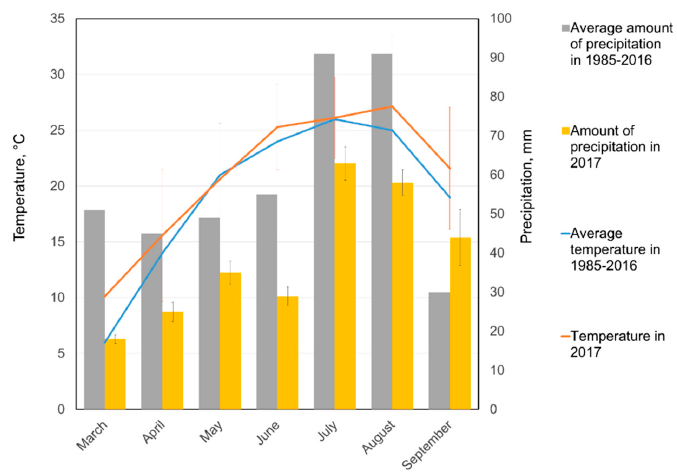
Figure 1. The comparison of weather conditions, such as monthly temperature and monthly precipitation, at the field locations during the cultivation period of the crop samples in 2017 with those values in years 1985–2016. Error bars indicate the monthly variability of temperature and precipitation in 2017. As the amount of rainfall on-site was considered to be su ffi cient for cultivation, the field plots were not artificially